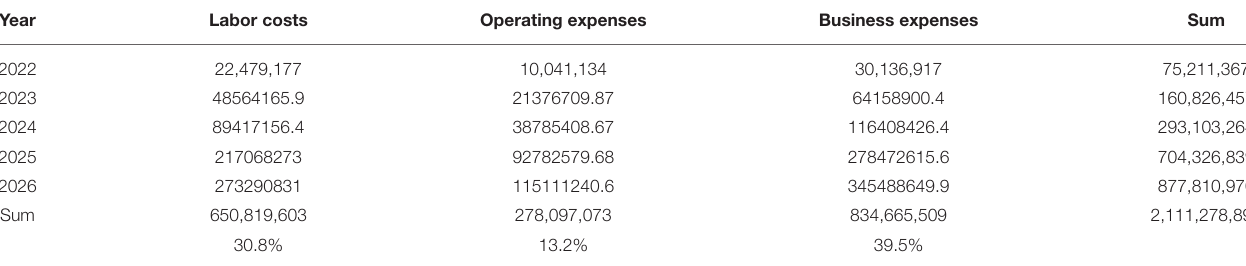
TABLE 11 | Estimated increase in cost by item of integrated care program due to expansion of program targets.